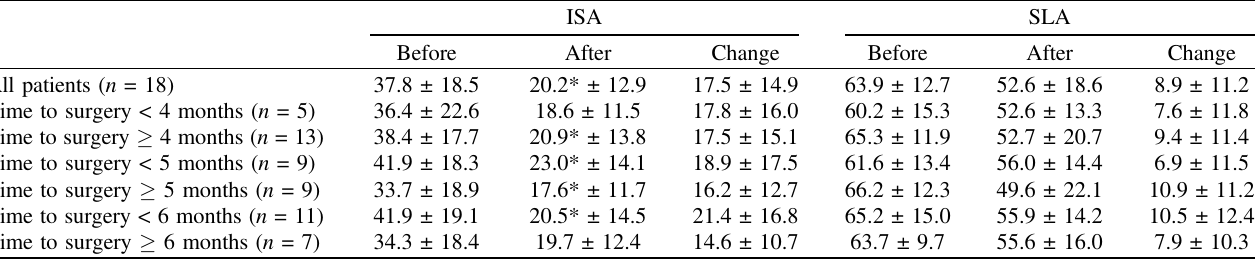
Table 1. Period from injury to surgery and changes in the intrascaphoid angle (ISA) and scapholunate angle (SLA) between before and after surgery.